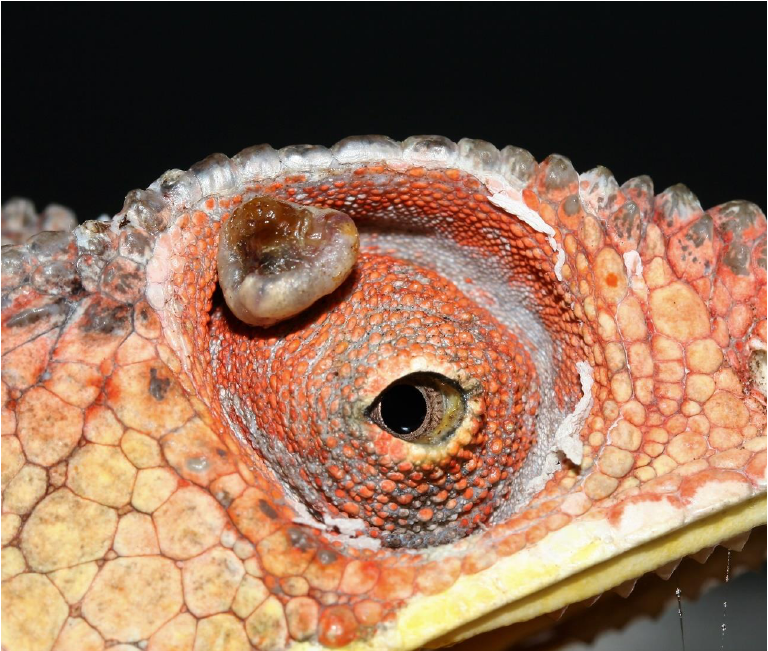
Figure 2. Macroscopic multicentric nodular, crateriform dermal lesion located at the dorsal part of the eyelid in panther chameleon 1 ( Furcifer pardalis ) that was histologically diagnosed as a keratoacanthoma with malignant transformation.